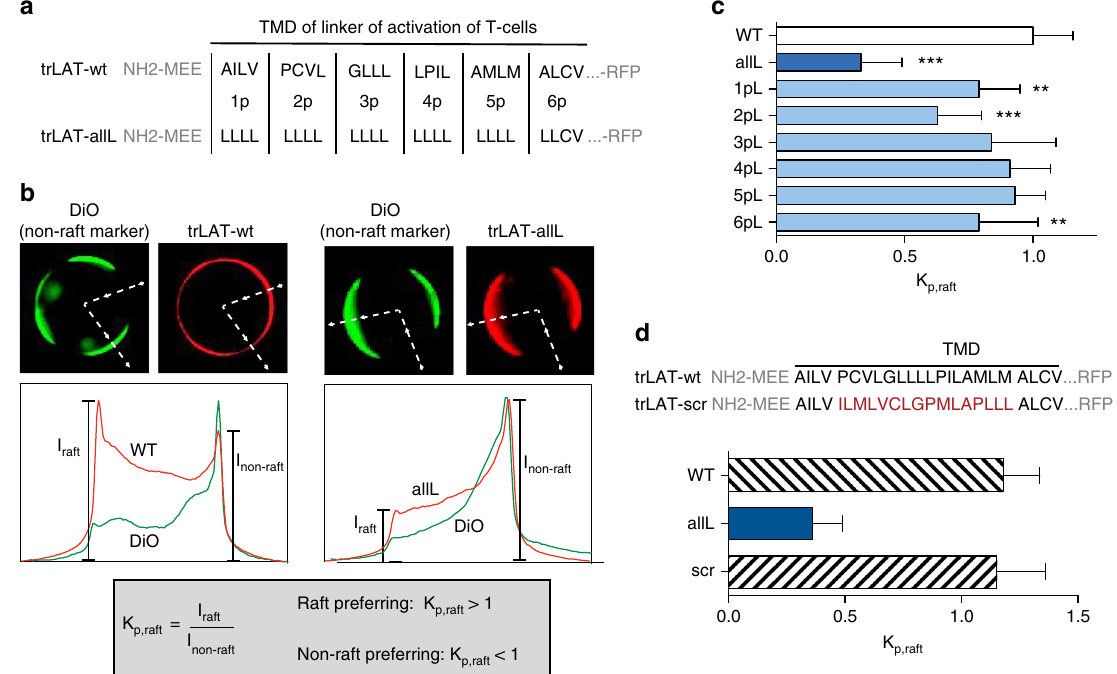
Fig. 1 Raft-targeting features distributed over the TMD of LAT. a Sequences of TMDs used to determine the localization of the raft-targeting feature. Mutations were made to either the entire TMD sequence (trLAT-allL) or to individual amino acid quartets (e.g. 1pL). b Example of quanti fi cation of raft partitioning in GPMVs. A protein of interest (trLAT; red) is expressed in cells, which are then stained with a lipid dye (F-DiO; green) with known phase preference (non-raft phase for F-DiO). The dye is used to identify the non-raft phase in GPMVs, and the relative fl uorescence intensity of the protein in the raft versus non-raft phase gives the raft partition coef fi cient, K p,raft . Mutating all TMD residues to Leu (trLAT-allL) decreases the raft af fi nity relative to the native LAT TMD (trLAT-wt). Vesicles in images are 5 – 10 μ m in diameter. c The TMD was divided into 6 parts, that were mutated individually to Leu to identify the location of the raft-targeting features. None of these partial mutations reproduced the lack of raft af fi nity of the all-Leu construct, suggesting a distributed feature responsible for the raft af fi nity of the LAT TMD. d The 16 core residues of the LAT TMD were randomized to create trLAT-scr. This construct partitioned at parity with the wild-type TMD, suggesting amino acid properties, rather than sequence, as the key determinant of raft af fi nity. Average ± SD for 3 – 5 independent trials, each with > 10 vesicles/condition; ** p < 0.01; *** p < 0.001, one-way ANOVA. Sequences and partitioning values for all variants are given in Supplementary Table